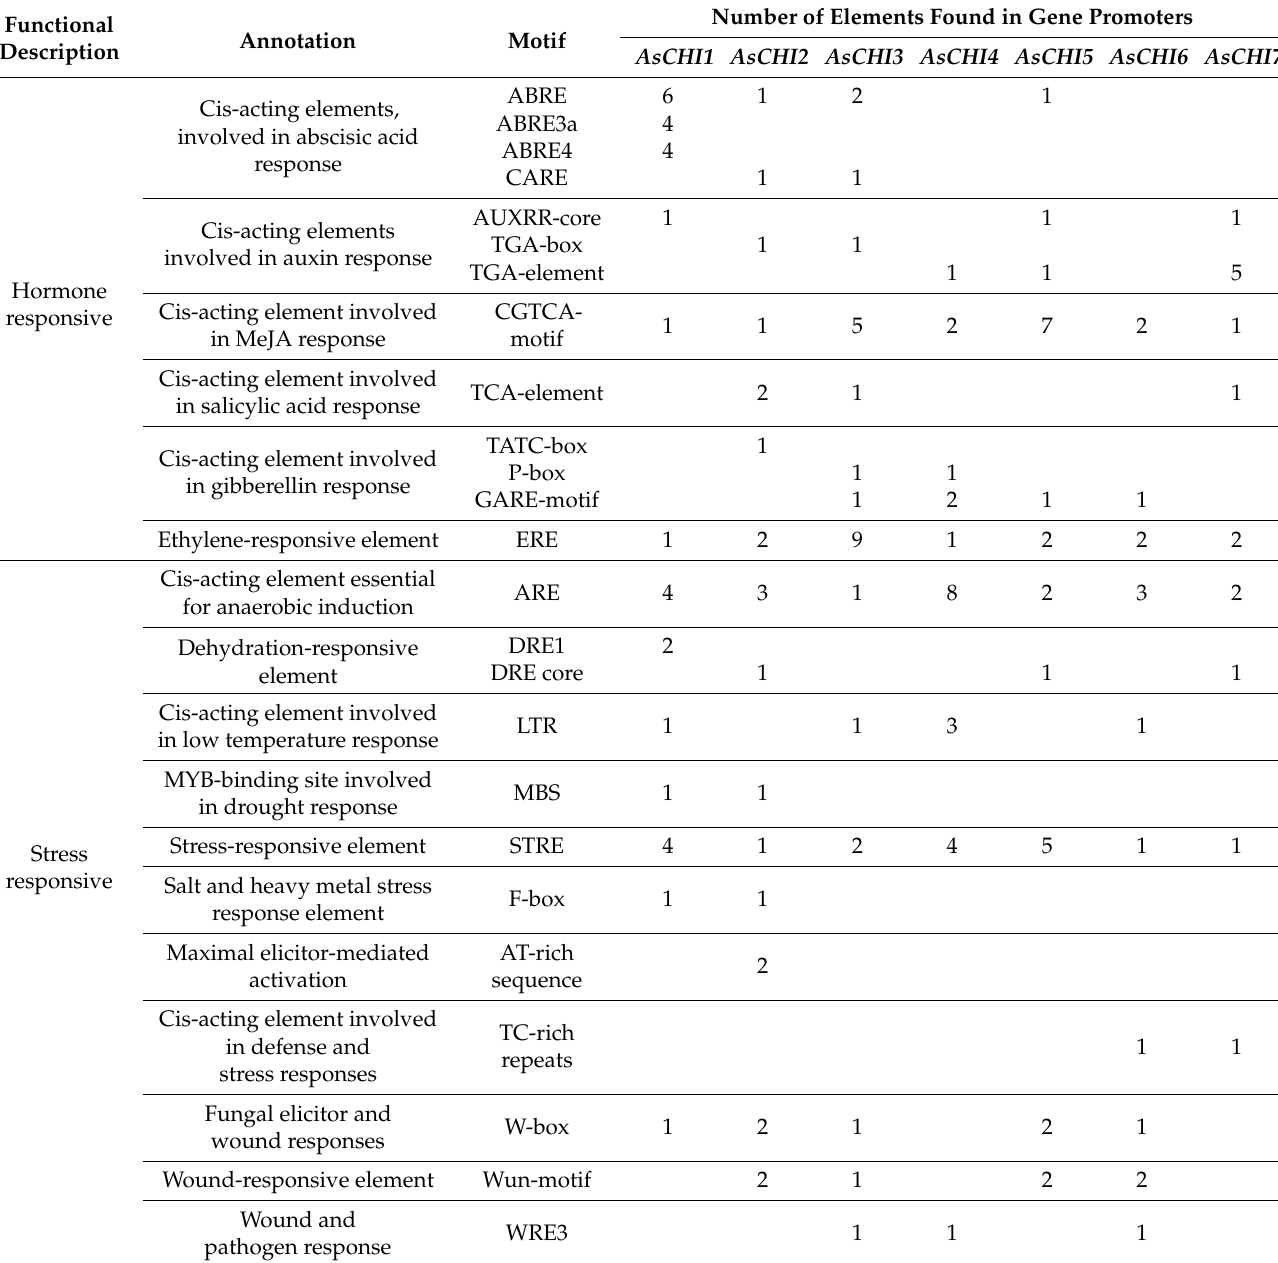
Table 3. Regulatory elements found in silico in the promoter sequences of Allium sativum cv. Ershuizao class I chitinase genes. MeJA: methyl